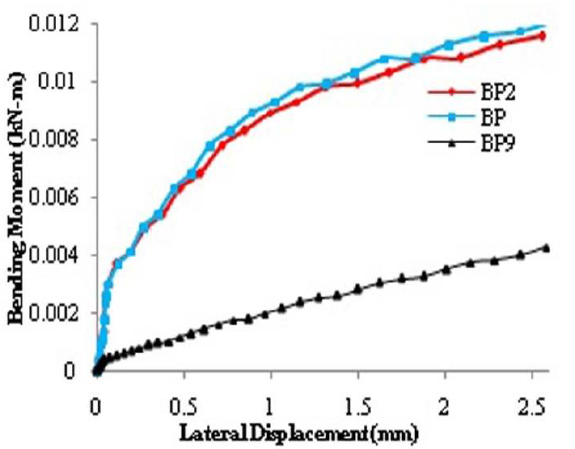
Fig. 16. Predicted different pile group bending moment results at 3D pile spacing of bamboo pipe piles in loose dense layers for slenderness ratio as 38.